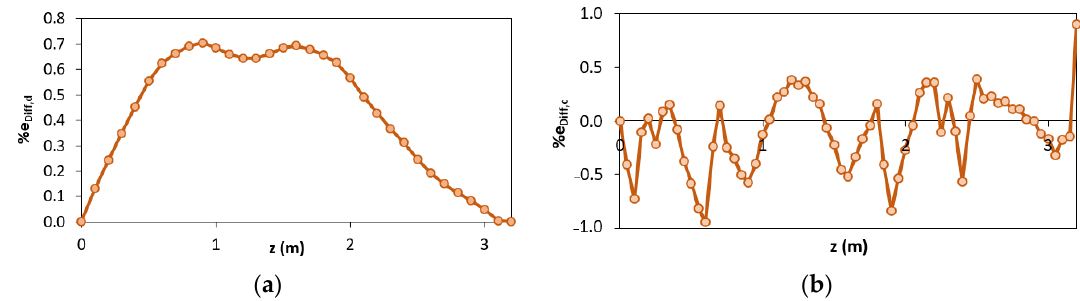
Figure 22. Percentage differences related to: ( a ) displacements (e Diff,d ); ( b ) curvatures (e Diff,c ).